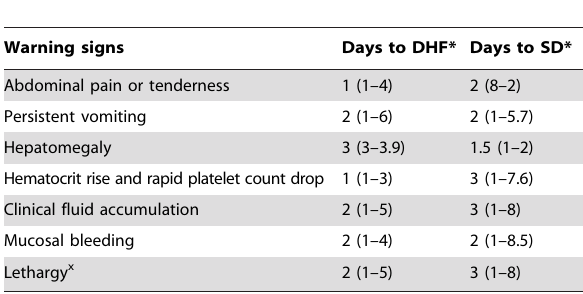
Table 5. Duration from the onset of warning signs to dengue hemorrhagic fever (DHF) and severe dengue